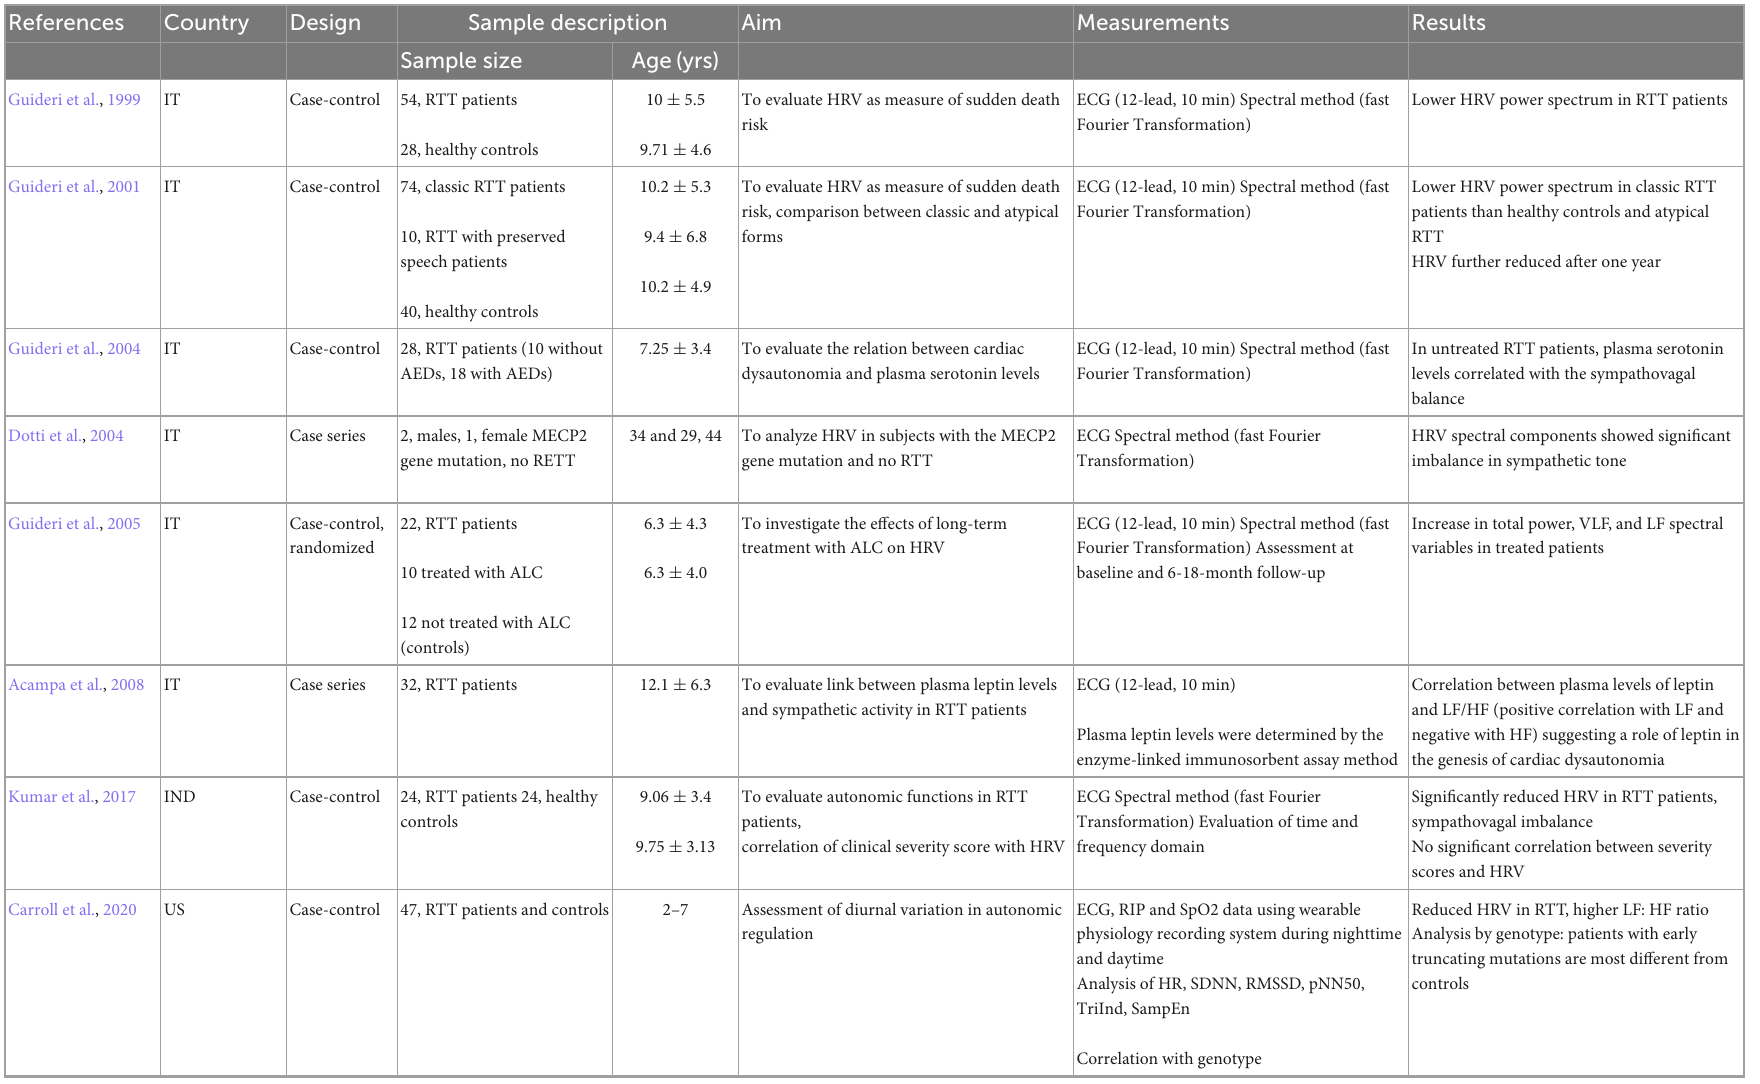
TABLE 1 Main characteristics of the studies focused on HRV analysis included in the